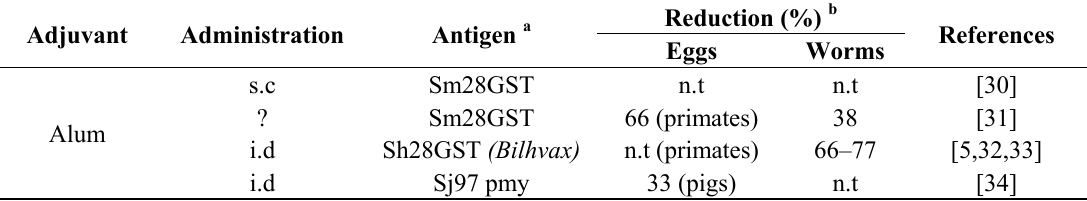
Table 3. Alum-adjuvanted Schistosoma vaccine candidates.